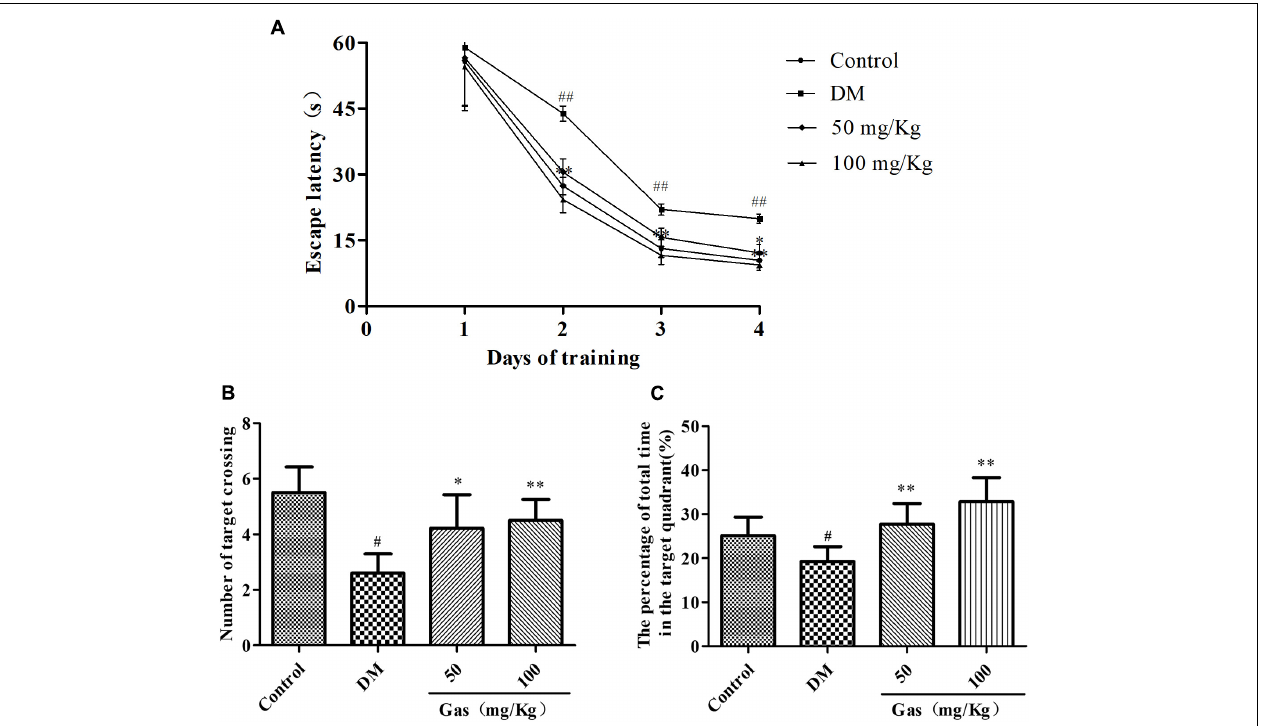
FIGURE 5 | Gas ameliorates cognitive dysfunction in DM rats. (A) Escape latency of the 4-day hidden-platform test. (B) Number of target crossing in the probe trial. (C) Percentage of total time spent in target quadrant in the probe trial. All data are expressed as means ± SD for 10 rats in each group. # P < 0.05, ## P < 0.01, compared with the control group. ∗ P < 0.05, ∗∗ P < 0.01, compared with the DM